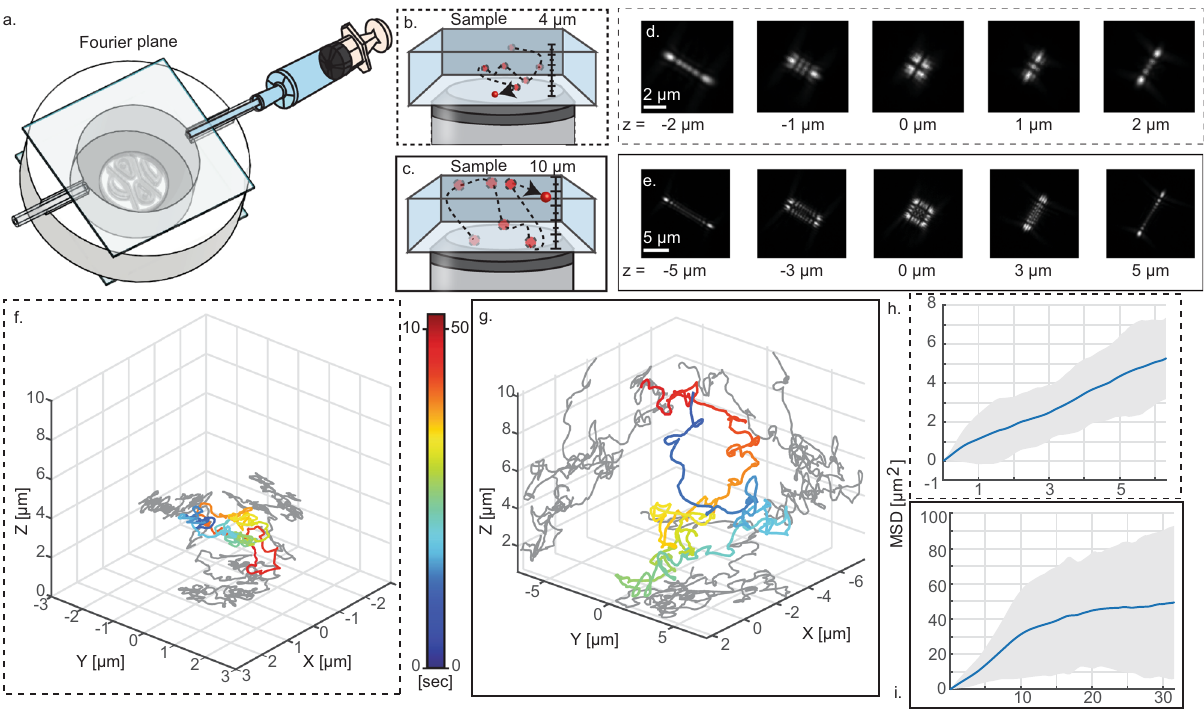
Fig. 2 The results of 3D single-particle tracking experiments. a Illustration of Z-range tunability by liquid replacement. b , c Different tracking ranges 4 and 10 μ m, respectively, obtained using the same device with different liquids ( n ref = 1.41560, 1.41897). d , e Corresponding experimental Z-stacks of a fl uorescent microsphere. f , g The reconstructed trajectories in different ranges respectively. A larger depth range enables longer observation. h , i Corresponding mean squared displacement (MSD) plots. Dashed (continuous) lines refer to the 4 μ m (10 μ m)